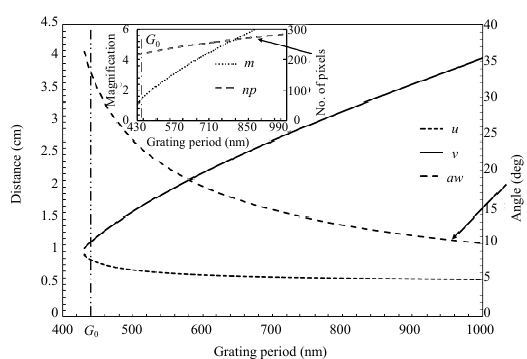
Fig. 4 Relation between aw , u , v , m and number of pixels np that are covered by the spectrum (550 nm–650 nm), for grating period (430 nm–1000 nm), with the incident angle of 40 ˚